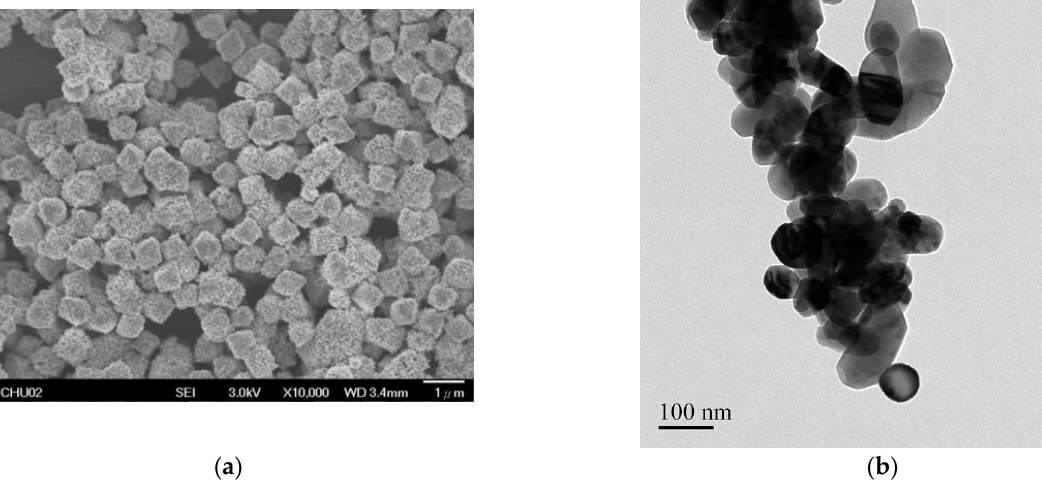
Figure 1. Morphologies of copper oxide particles: ( a ) SEM image of submicron copper oxide particles (SMPO), and ( b ) TEM image of copper oxide nanoparticles (NPO).